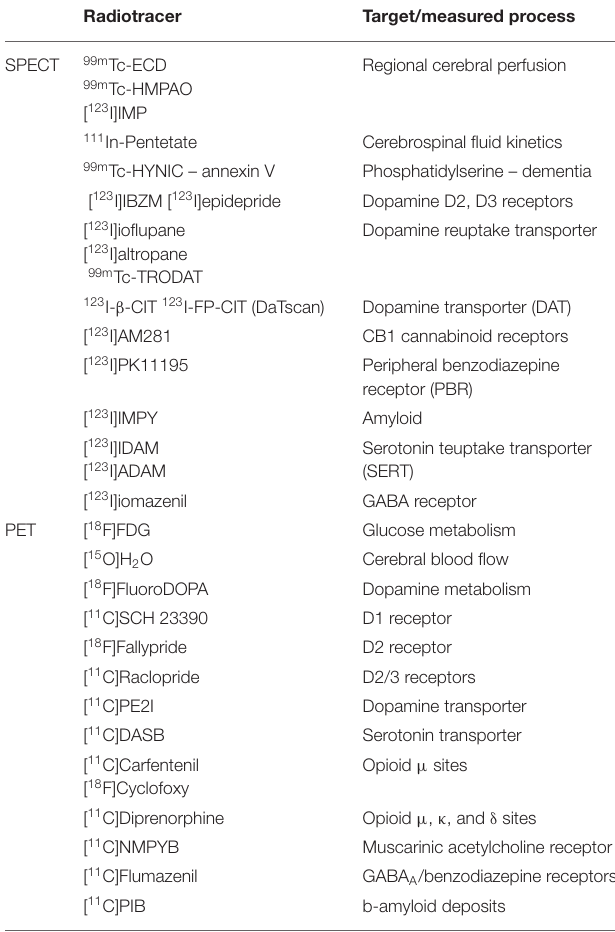
TABLE 3 | Several brain radiotracers currently used in small animal neurological imaging (adapted from Brooks, 2005).